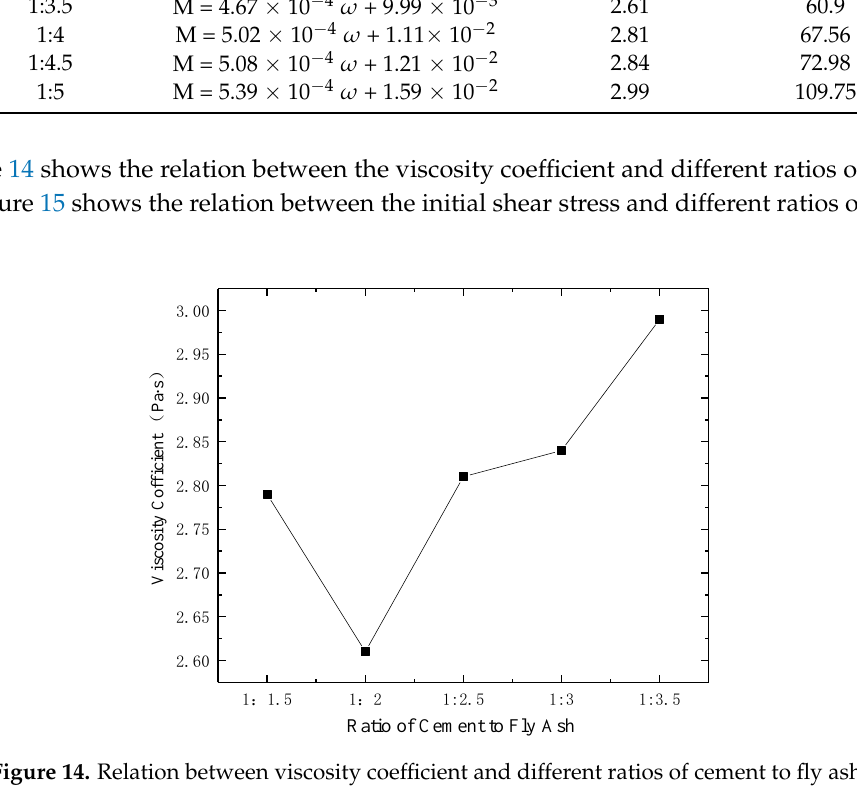
Figure 14. Relation between viscosity coefficient and different ratios of cement to fly ash.